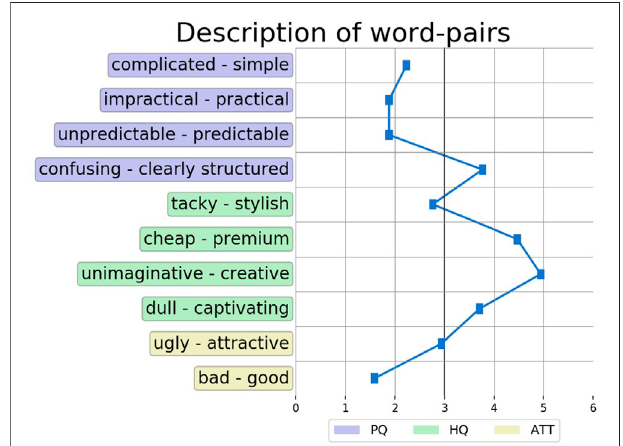
FIGURE 11 | Word-pair visualization of the mean values of the AttrakDiff questionnaire. Each word-pair represents a single item within the